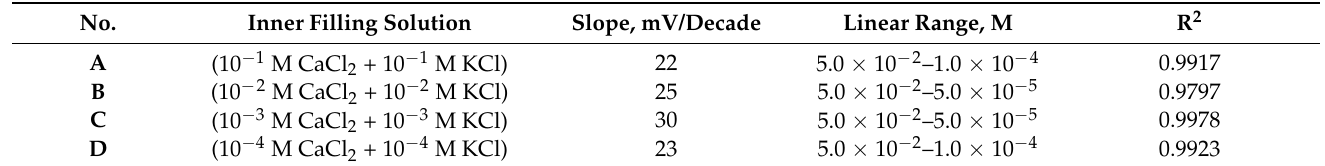
Table 3. Effect of inner filling on the performance of Ca-selective electrode based on DNA with DOP plasticizer.